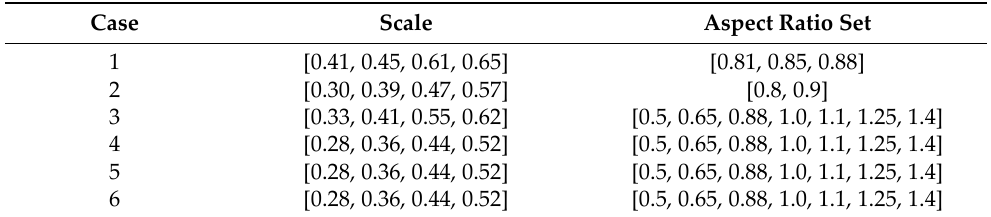
Table 3. Scale and aspect ratio of anchor boxes for use in the multi-currency (KRW, USD, INR, and JPY) recognition model .